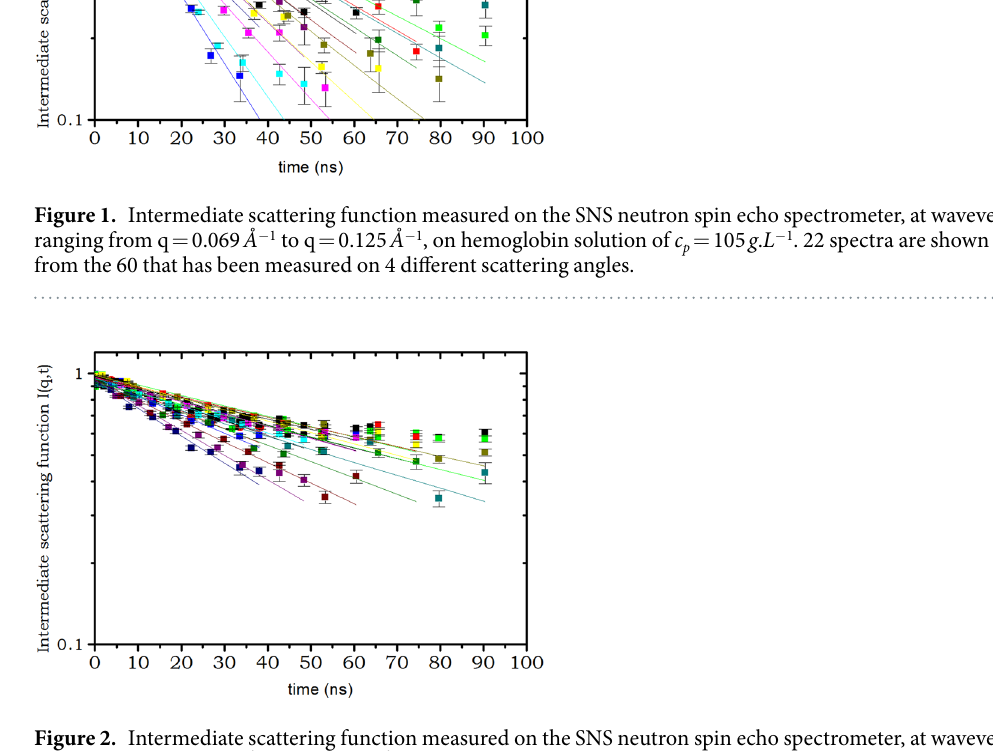
Figure 2. Intermediate scattering function measured on the SNS neutron spin echo spectrometer, at wavevector ranging from q = 0.069 Å − 1 to q = 0.25 Å − 1 , on hemoglobin solution of c p = 327 g . L − 1 .